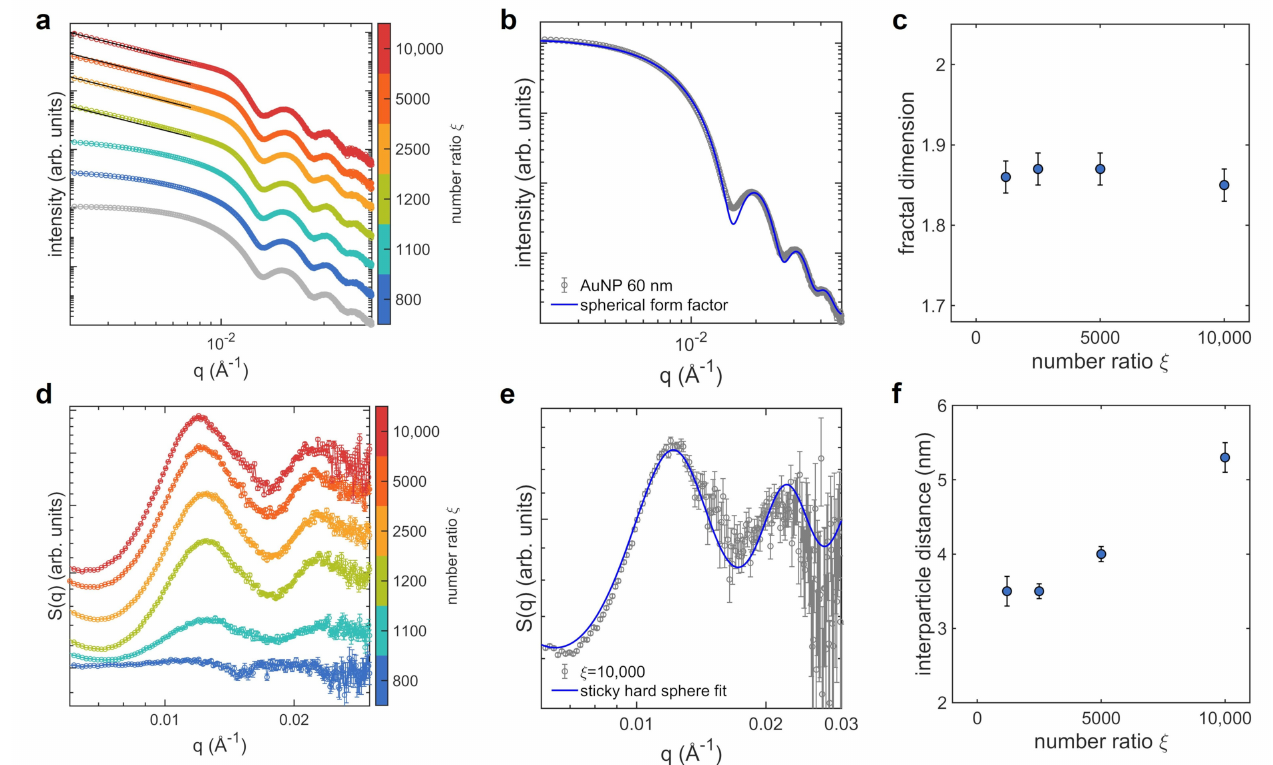
Figure 2. SAXS analysis of the AuNPs clusters morphology as a function of the protein concentration (the lysozyme-AuNPs number ratio ξ is represented by the colorbar), performed at 25 °C and pH 6.5: ( a ) SAXS curves (circles, the curve in gray is acquired on the AuNPs stock solution) and power-law decay fitting curves (black lines, only for curves at ξ ≥ 1200 that show a clear power-low decay in the q -range from 0.002 to 0.0072 Å − 1 ); ( b ) fit of the SAXS curve of the AuNPs stock solution (gray circles) to a spherical form factor (blue line); ( c ) fractal dimension as a function of ξ ; ( d ) structure factors at varying ξ ; ( e ) representative fit of a structure factor S ( q ) (gray circles, sample at ξ = 10,000) to a sticky hard spheres model (blue line); ( f ) interparticle distance as a function of ξ . SAXS curves and structure factors are shifted vertically for